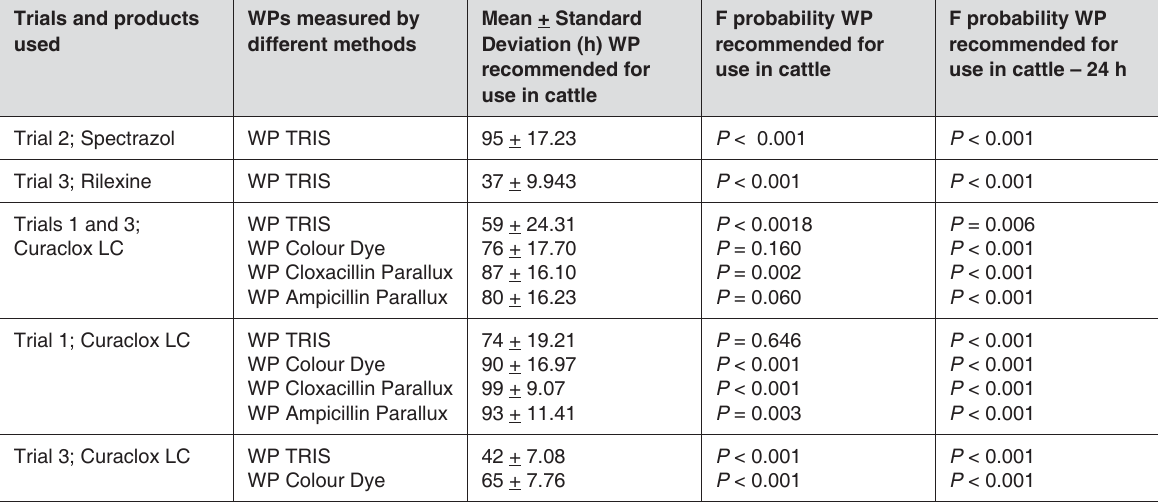
TABLE 1 Withdrawal period (WP) of intramammary antibiotics of goats compared to withdrawal periods (WPs) recommended for use in cattle with or without the 24 h safety margin (one sample t-tests) Trials and